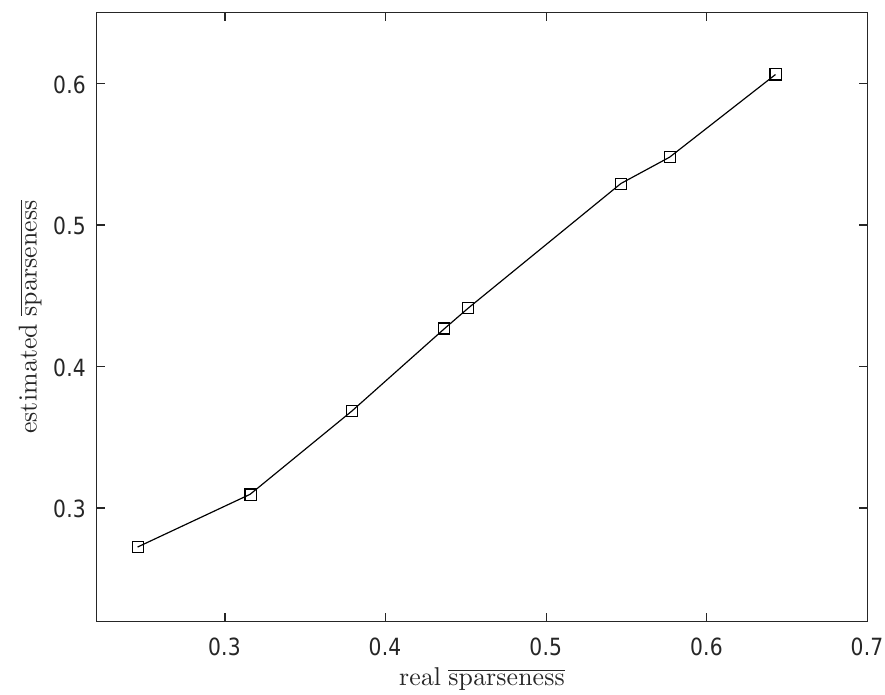
Figure 2. The real average sparsity level and the estimated average sparsity level.